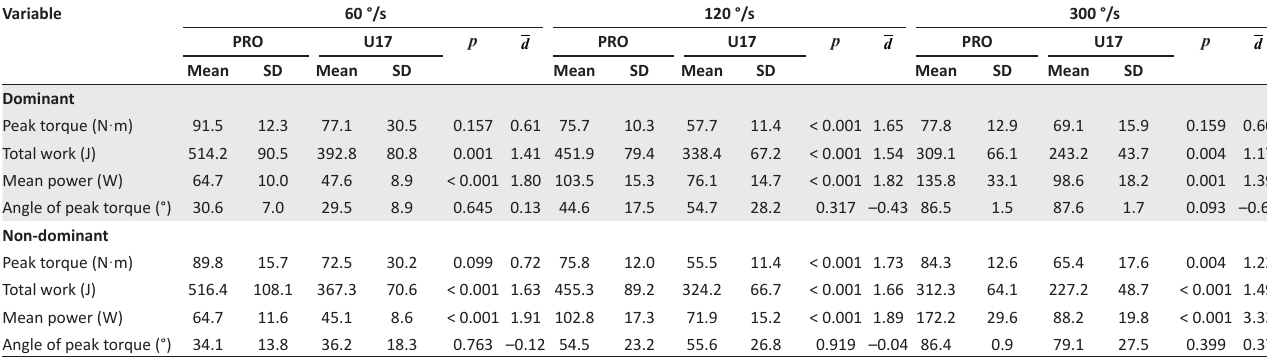
TABLE 2: Isokinetic parameters of flexor muscle assessments.